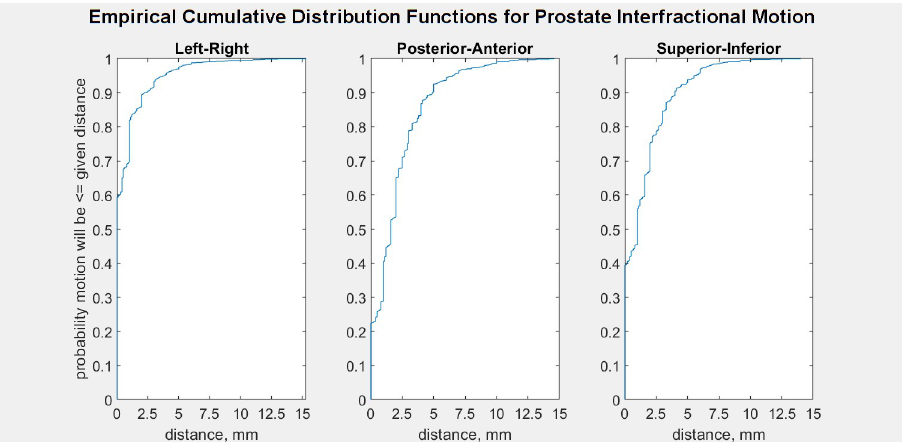
Fig 4. Empirical cumulative distribution function of prostate interfractional distance. Distance from the planning position along each